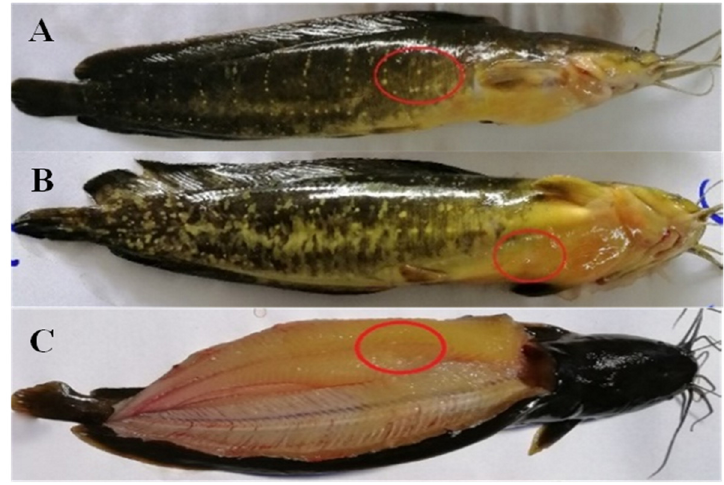
Figure 1. Digital image for site color measurement (circle) of body skin ( A ), abdominal skin ( B ), and muscle ( C ) of bighead catfish.